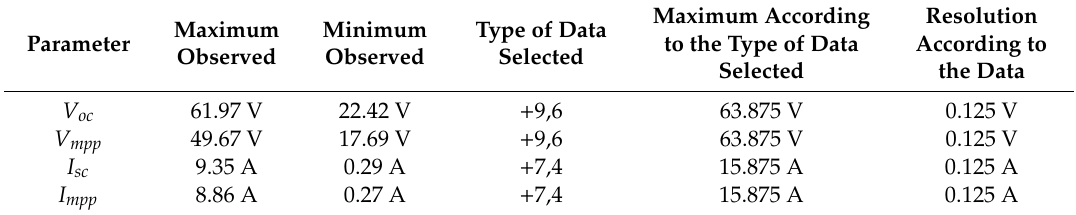
Table 1. Data obtained from the analysis of the photovoltaic panels (PVPs) for the model parameters.